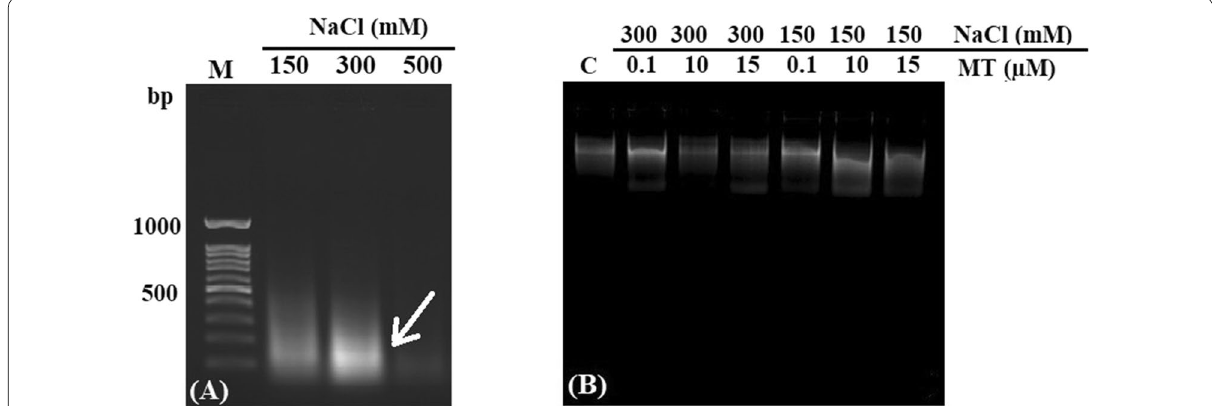
Fig. 3 DNA degradation in salt-stressed alfalfa root meristem. Arrows indicate smear and DNA Laddering ( A ). Inhibition of DNA laddering after treatment with melatonin (0.1, 10 and 15 µM) under 150 and 300 mM NaCl ( B )